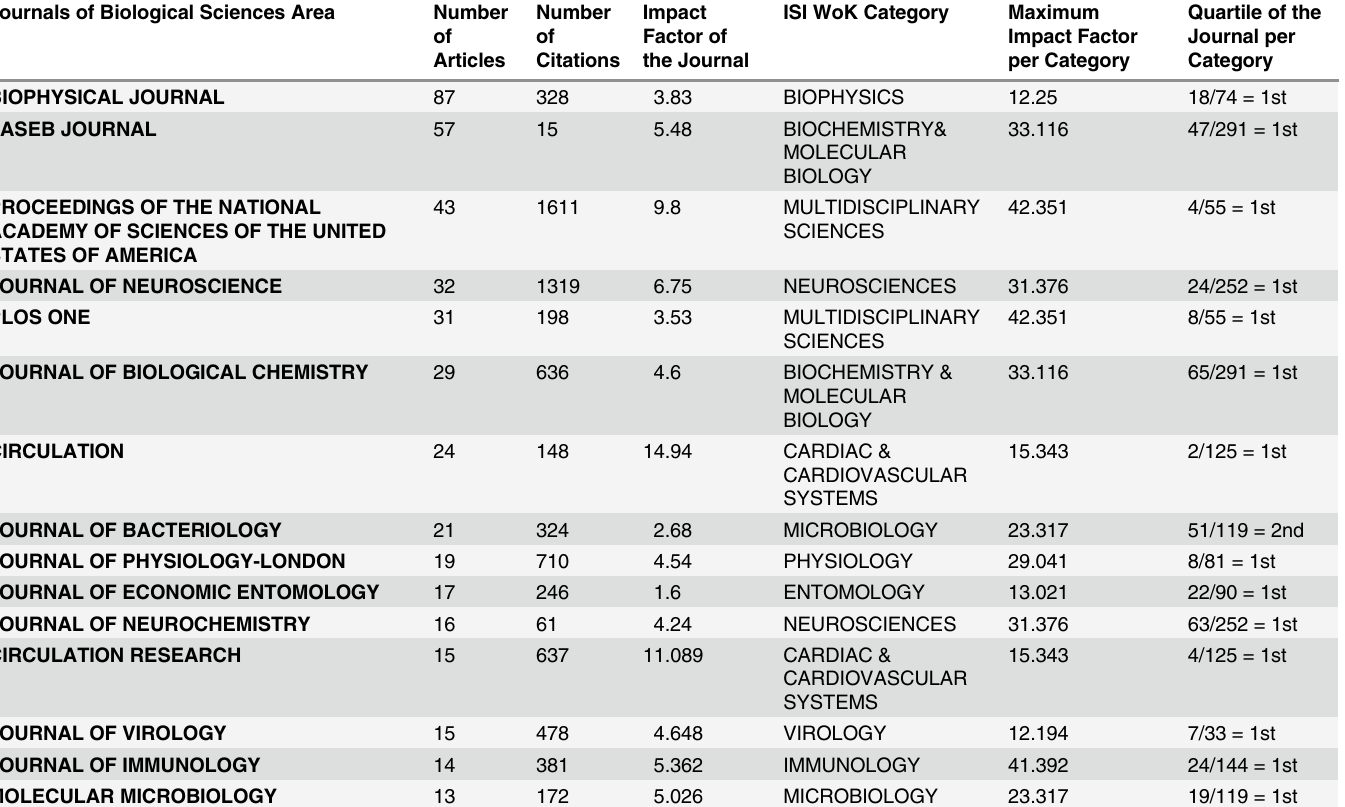
Table 16. Mainstream journals with the highest number of papers by the Mexican Diaspora in biological sciences with their citations (up to Decem- ber 2013) and JCR impact factors